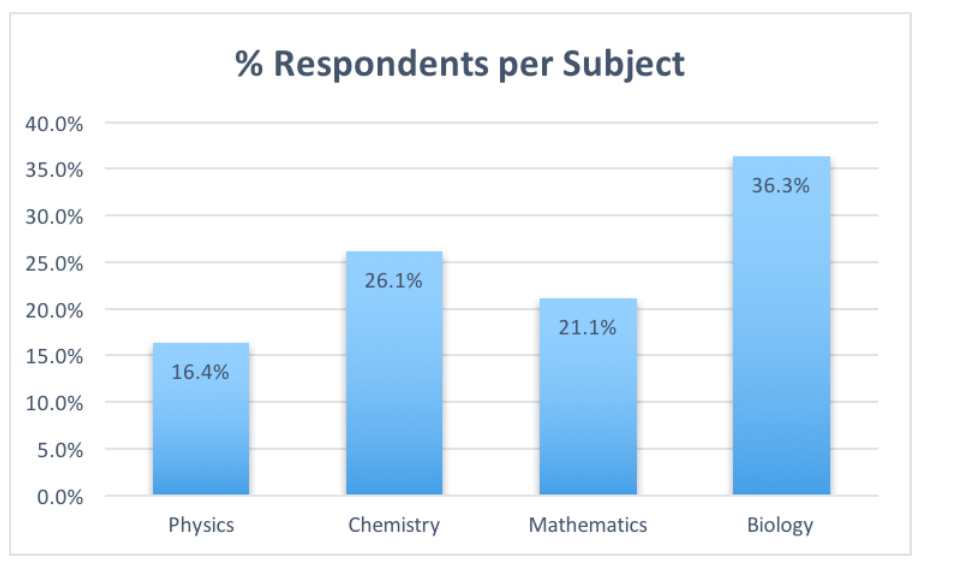
Figure 3. Respondents’ demographic profile per